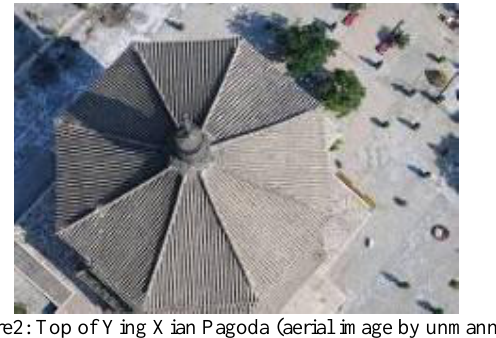
Figure2: Top of Ying Xian Pagoda (aerial image by unmanned helicopter )